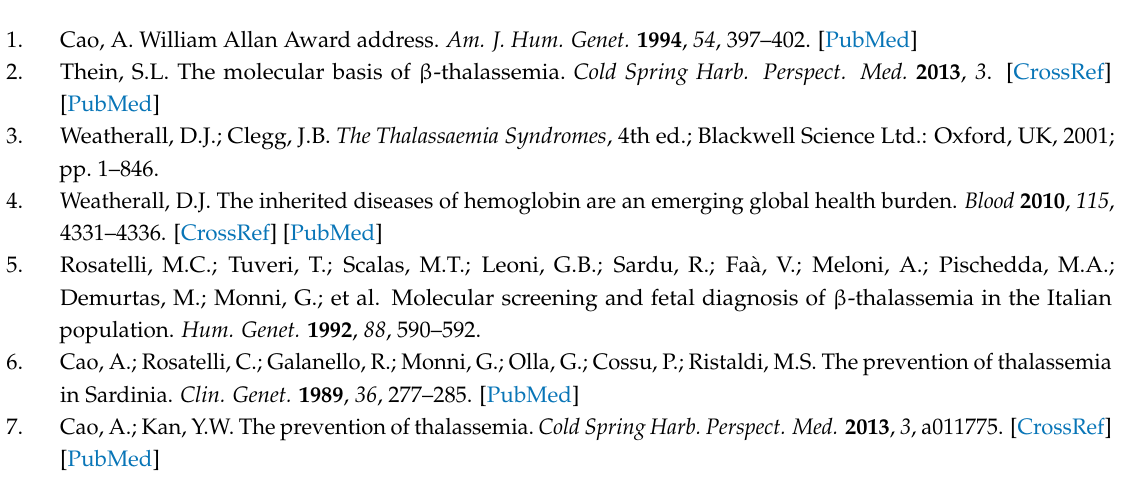
Figure 1. Fall in the birth rate of homozygous β-thalassemia in Sardinia.